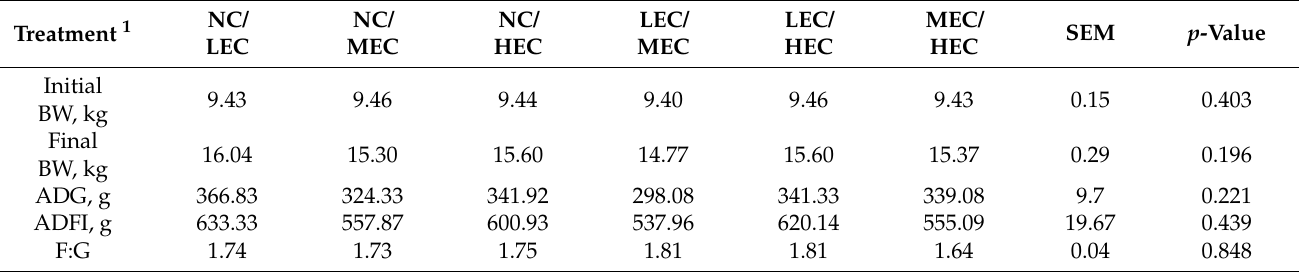
Table 2. Growth performance of piglets offered different gelatinization degrees of extruded corn in a two-way choice test in experiment 1 1 .